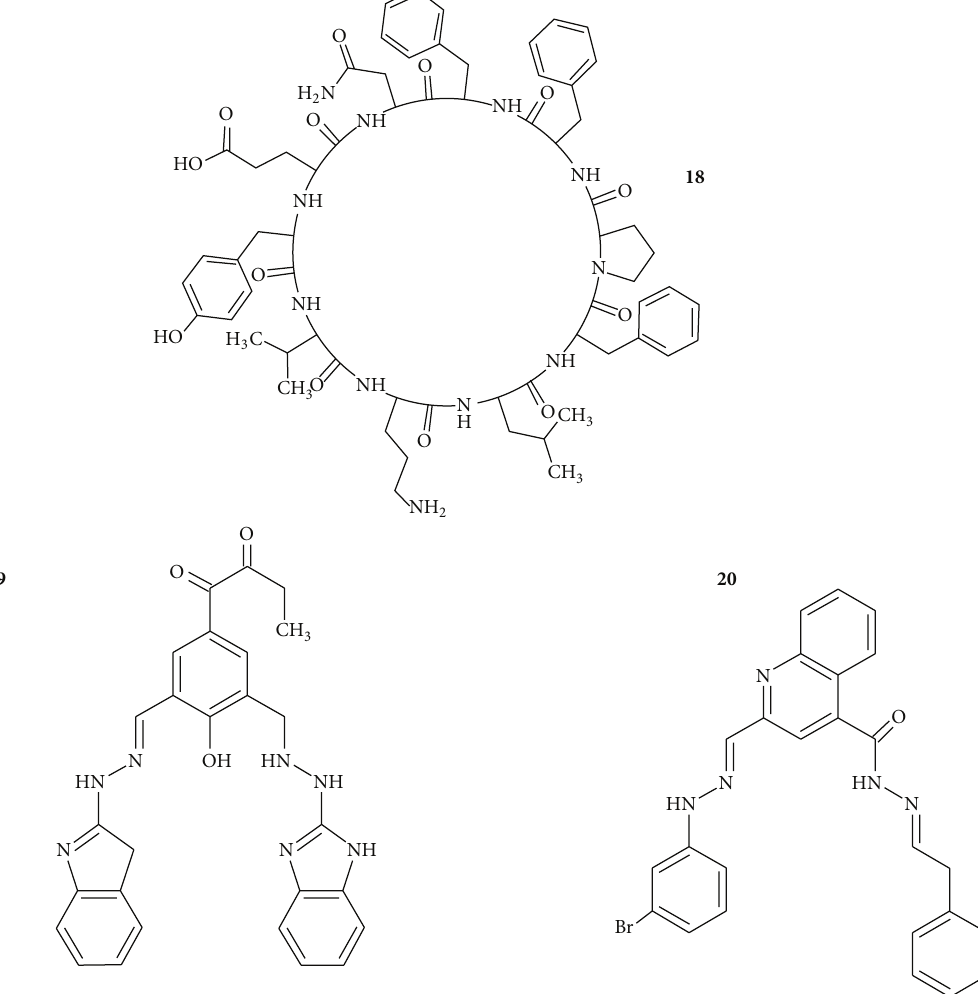
Figure 2: Top ranked 20 ligand structures. Ligand numbers only provided near to each ligand structure.